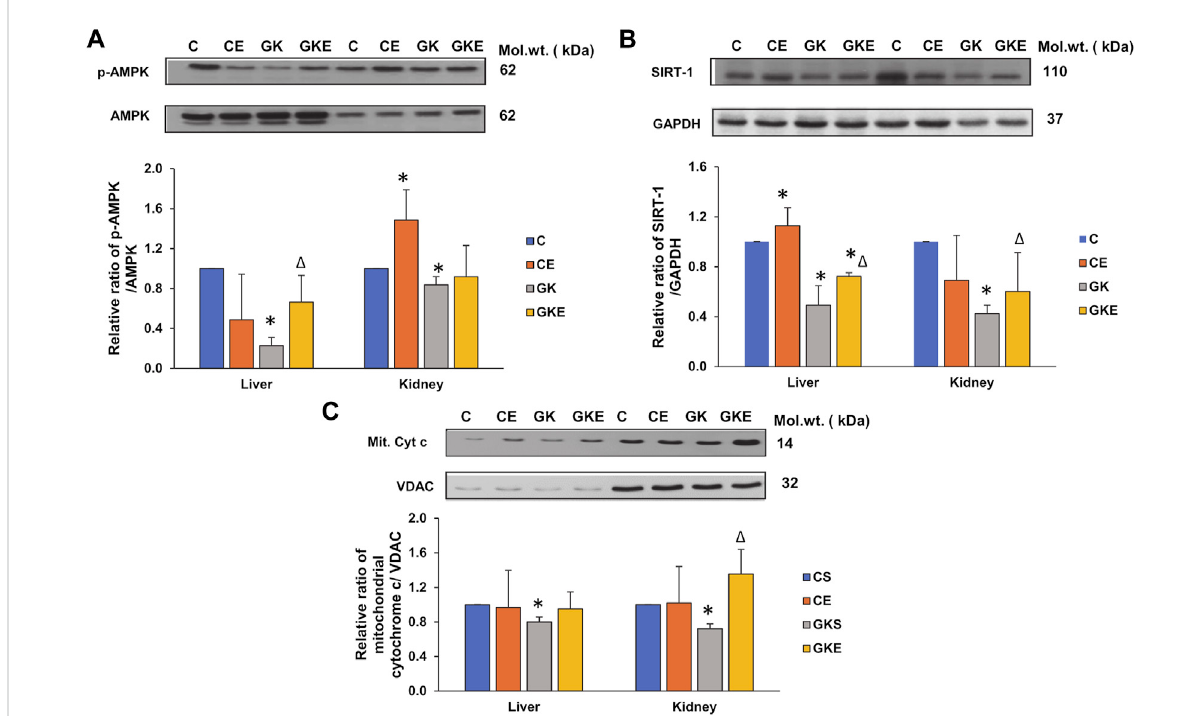
FIGURE 9 Exercise-induced alterations in the expression of energy regulator marker proteins in the liver and kidney of control Wistar (C) and diabetic GK (GK) and exercise-trained control (CE) and GK (GKE) rats ( n = 5). Cytosolic and mitochondrial fractions were electrophoretically separated by 7.5% – 12% SDS-PAGE, transferred onto nitrocellulose membranes, and immunoblotted with proteins regulating energy metabolism, p-AMPK (A) , SIRT-1 (B) , and mitochondrial cytochrome c (C) and visualized using the Sapphire Biomolecular Imager (Azure Biosystems, Dublin, OH, United States) or by exposure to X-ray fi lms. Total protein and GAPDH were used as loading controls for p-AMPK and SIRT-1 respectively, and VDAC for the mitochondrial fraction. Immunoreactive bands were quantitated using Image Studio Lite, ver.5.2 (LI-COR Biosciences, Lincoln, NE, United States). Histograms represent the relative ratio of protein over their respective loading controls from three independent experiments. Statistical signi fi cance is shown as asterisks, which was fi xed as p < 0.05 (* indicates statistical signi fi cance compared with control Wistar rat tissues while Δ indicates statisticalsigni fi cancecomparedwithdiabeticGKrattissues).MolecularweightsoftherespectiveproteinsareindicatedinkDa.Originalwesternblot fi gures are shown in Supplementary Figure